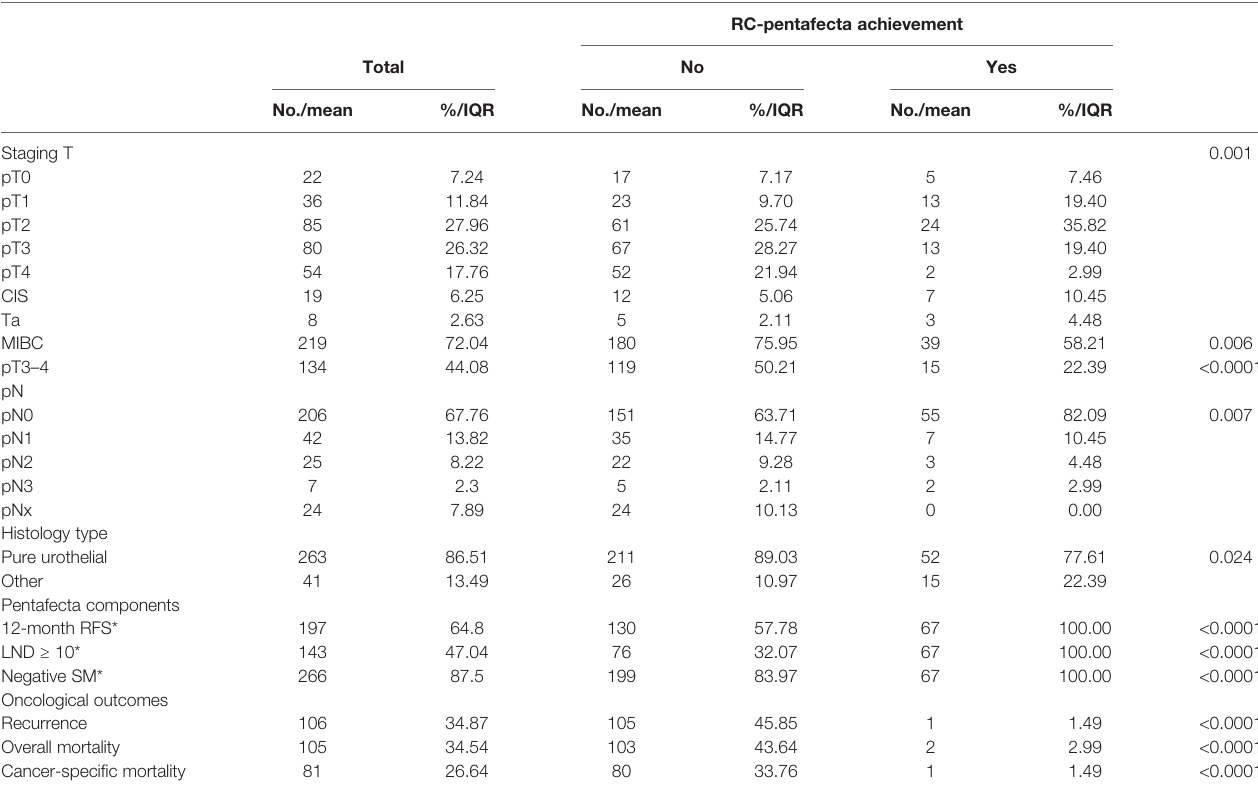
TABLE 4 | Oncological outcomes of patients who underwent RC and achieved or not pentafecta.